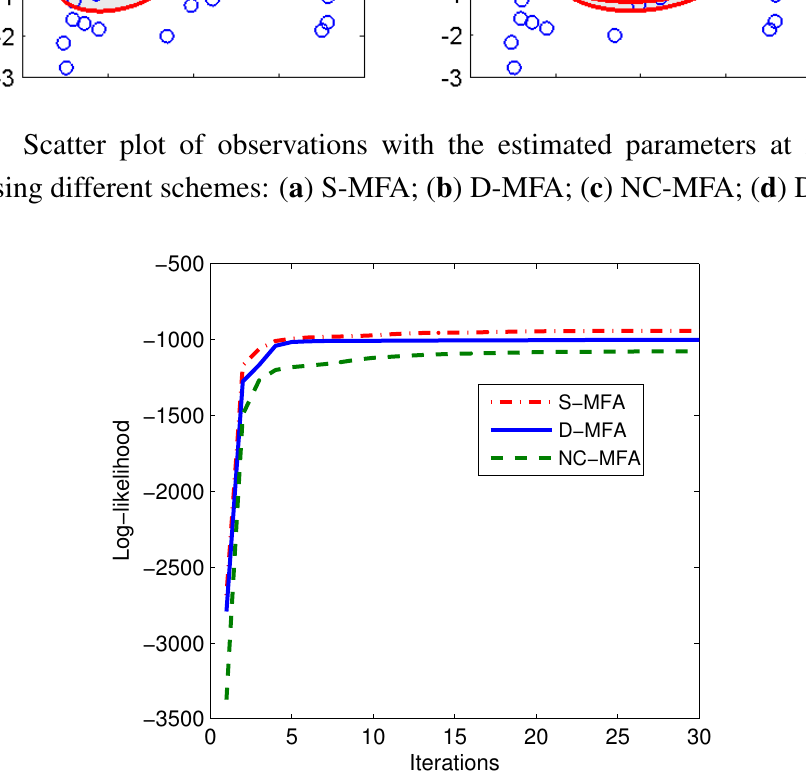
Figure 4. Log-likelihood changes of three MFA schemes during 30